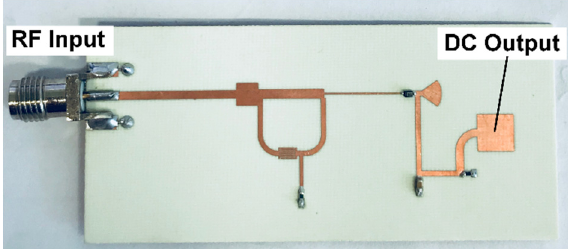
Figure 8. Fabricated detector board. The pad on the left has been included to ease the probing of the DC output.